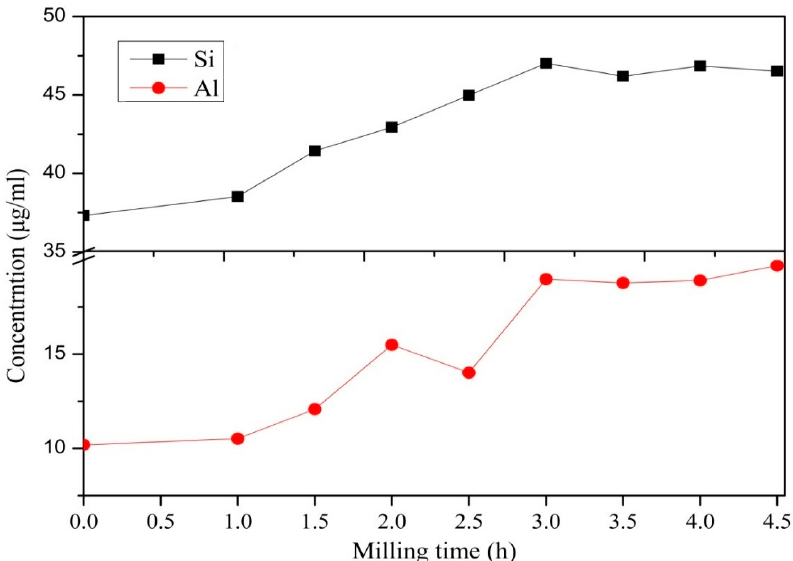
Figure 4. Si and Al leaching concentrations after mechanical activation of copper-mine tailings.